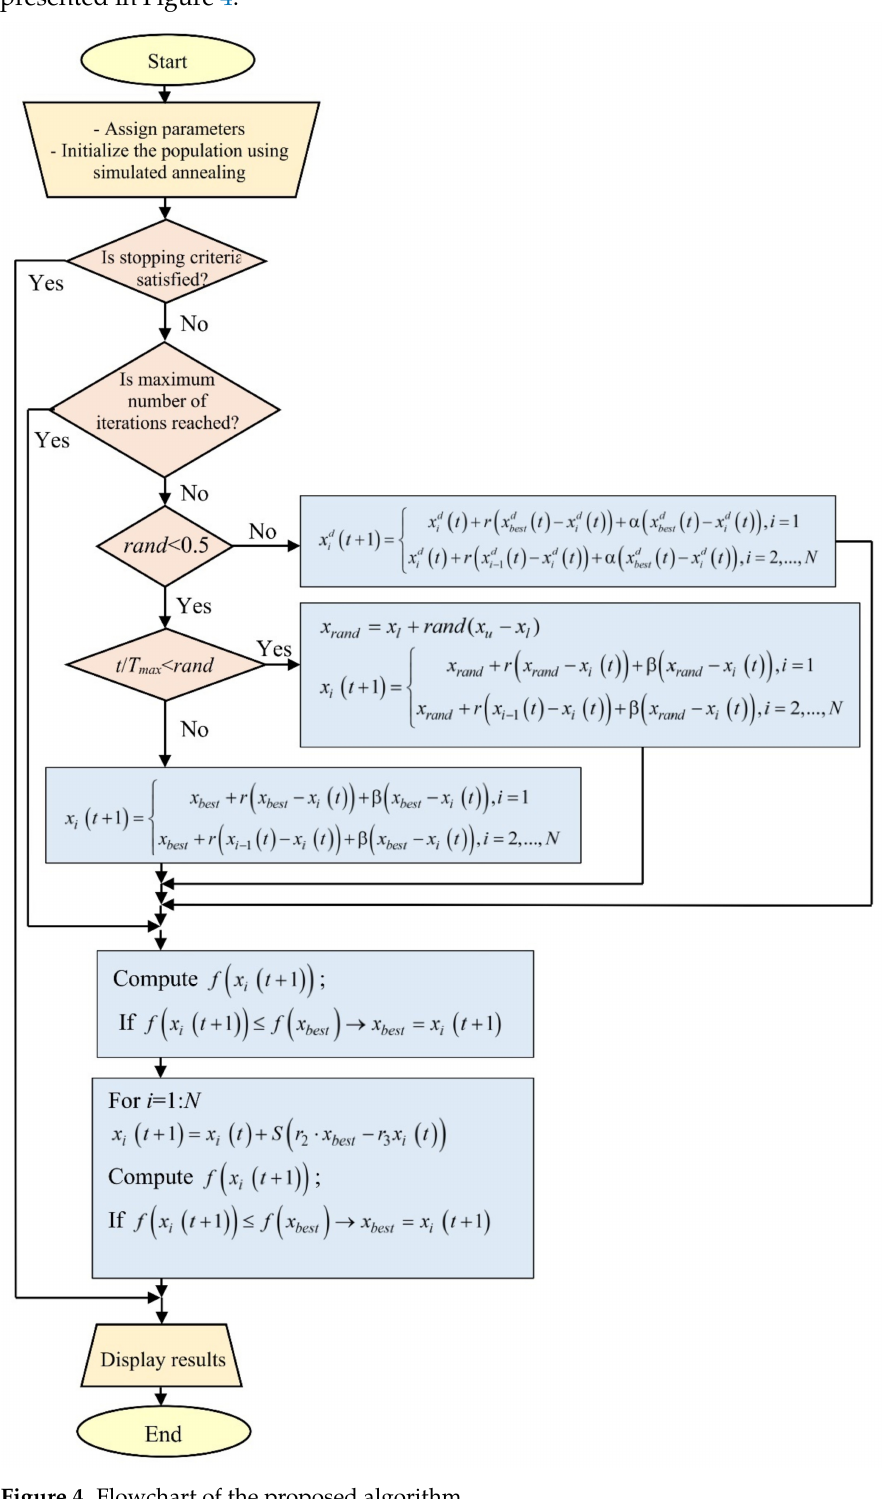
Figure 4. Flowchart of the proposed